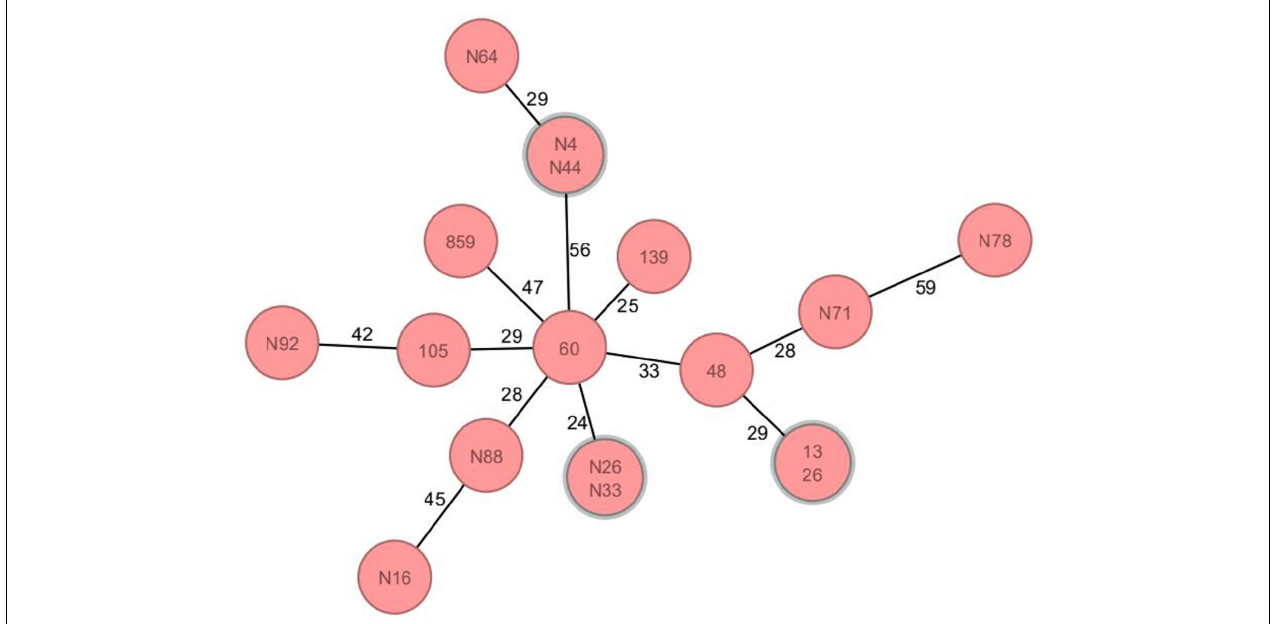
FIGURE 2 | Core genome multilocus sequence typing analysis of ST1193 isolates carrying bla CTX − M − 55 gene. Circles represent ST1193 isolates, and the number on each circle connecting line is the allele difference between the two isolates. Clonally related genetic complexes (=15 alleles difference) containing more than one patient are encircled in gray . There were no differential alleles between three pairs of isolates (N4&N44, N26&N33, and 13&26); furthermore, the number of differential alleles in other isolates was more than